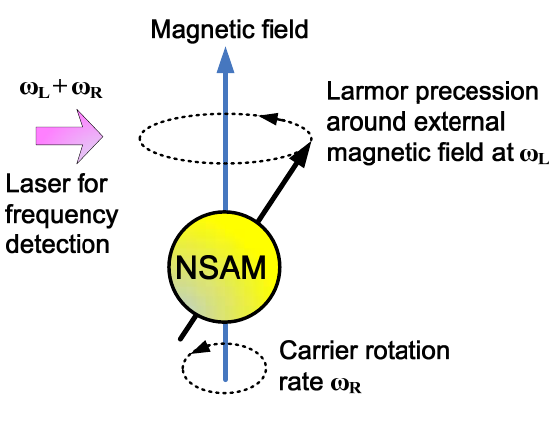
Figure 2. Principle of ASG based on